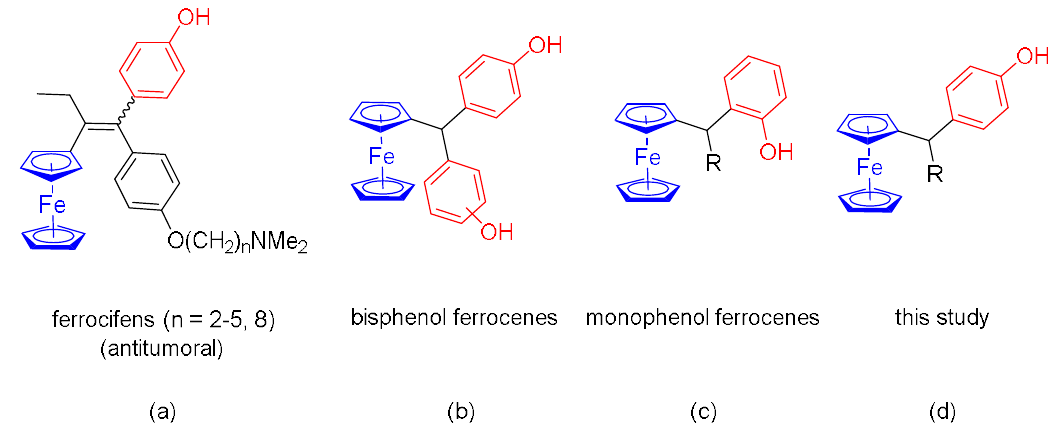
Figure 1. Phenol-ferrocene conjugates: ( a ) Ferrocifen family; ( b ) ferrocene bisphenol derivatives; ( c ) ortho -substituted ferrocenyl phenols previously developed in our group; ( d ) para -substituted ferrocenyl phenols reported in this study.